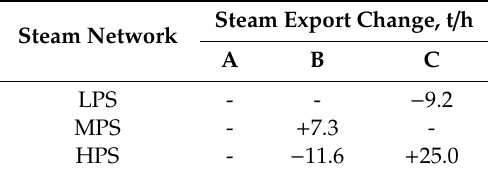
Table 5. The effect of proposed changes A, B and C on the steam amount supplied to steam networks.